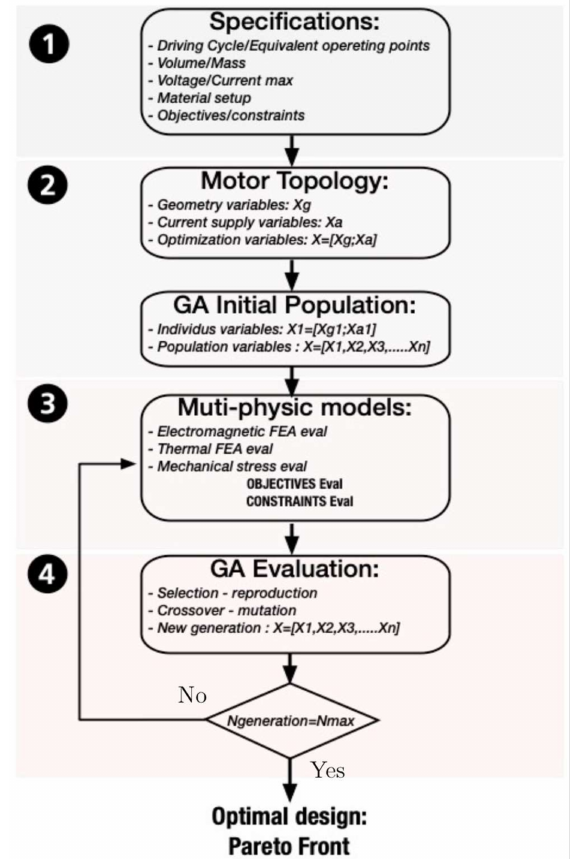
Figure 2. Optimization Algorithm Flow